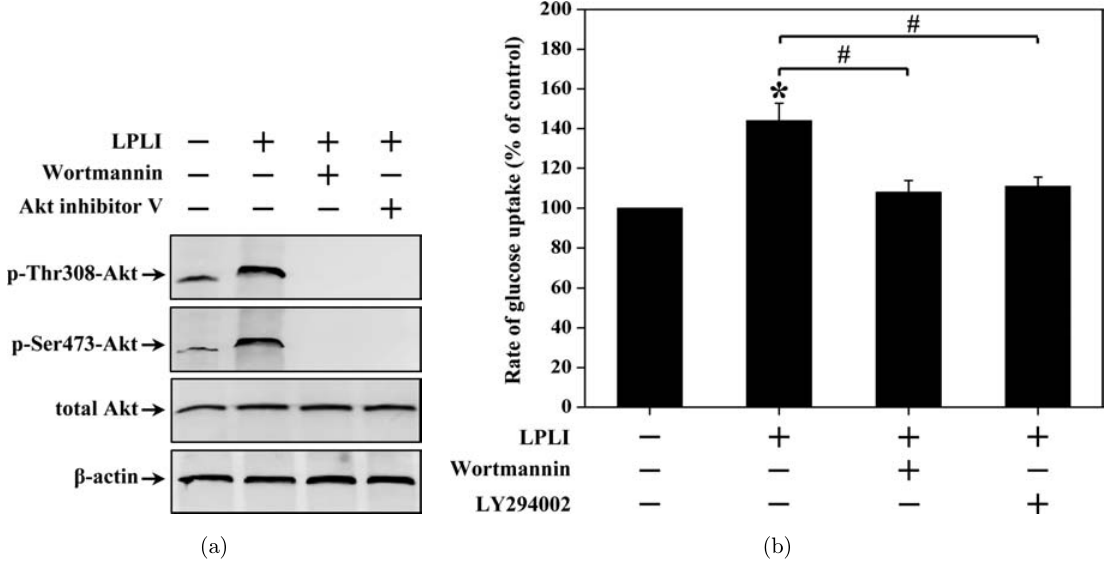
Fig. 3. PI3-K/Akt regulates glucose uptake induced by LPLI. (a) 3T3-L1 adipocytes were serum-starved for 6 h and then treated with wortmannin or Akt inhibitor V for 2 h before LPLI (5 J/cm 2 ) treatment. The phosphorylation levels of Akt were detected by western blot analysis. (b) 3T3-L1 adipocytes were serum-starved for 6 h and then treated with wortmannin or LY294002 for 2 h before LPLI (5 J/cm 2 ) treatment. About 2 h later, the glucose uptake was measured. ( n ¼ 3, * p < 0 : 05 versus untreated group; # p < 0 : 05 versus indicated group), (c) was similar to (b). Akt speci¯c inhibitors (Akt inhibitor IV or Akt inhibitor V) were used and the glucose uptake was measured. ( n ¼ 3, * p < 0 : 05 versus untreated group; # p < 0 : 05 versus indicated